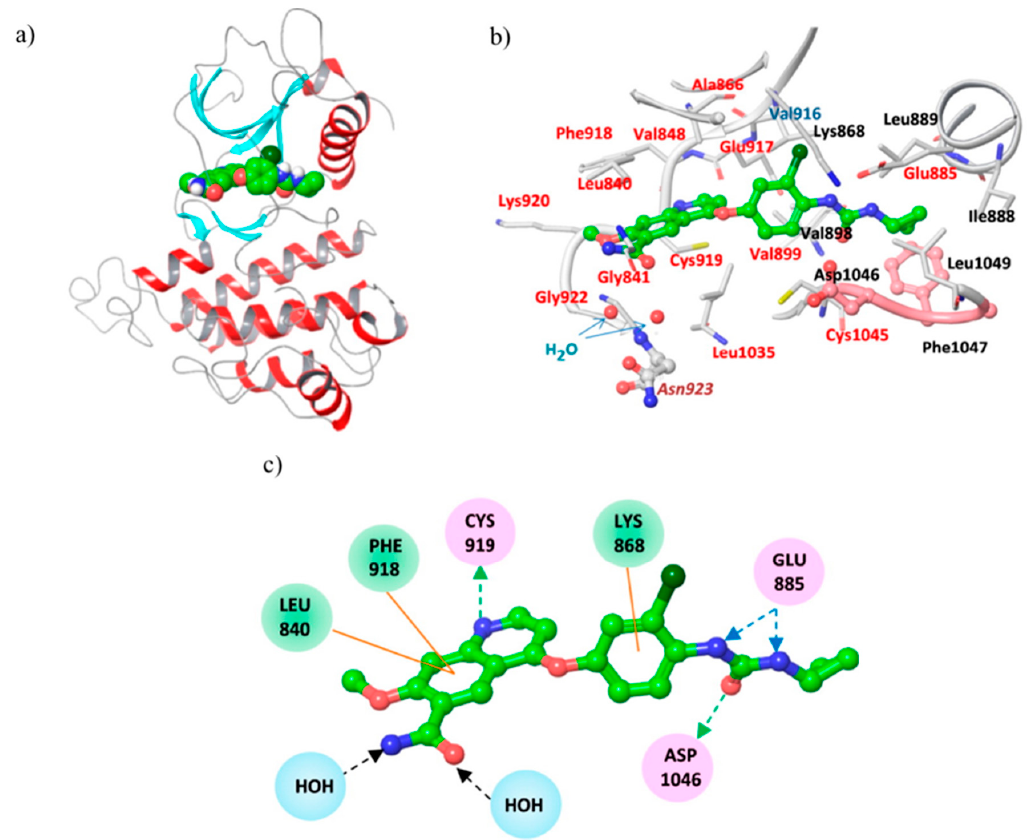
Figure 29. ( a ) crystal structure of lenvatinib in complex with VEGFR-2 (PDB id: 3WZD); ( b ) binding pocket of VEGFR-2 occupied by lenvatinib ; ( c ) scheme for interactions of lenvatinib in the VEGFR-2 binding pocket [130].